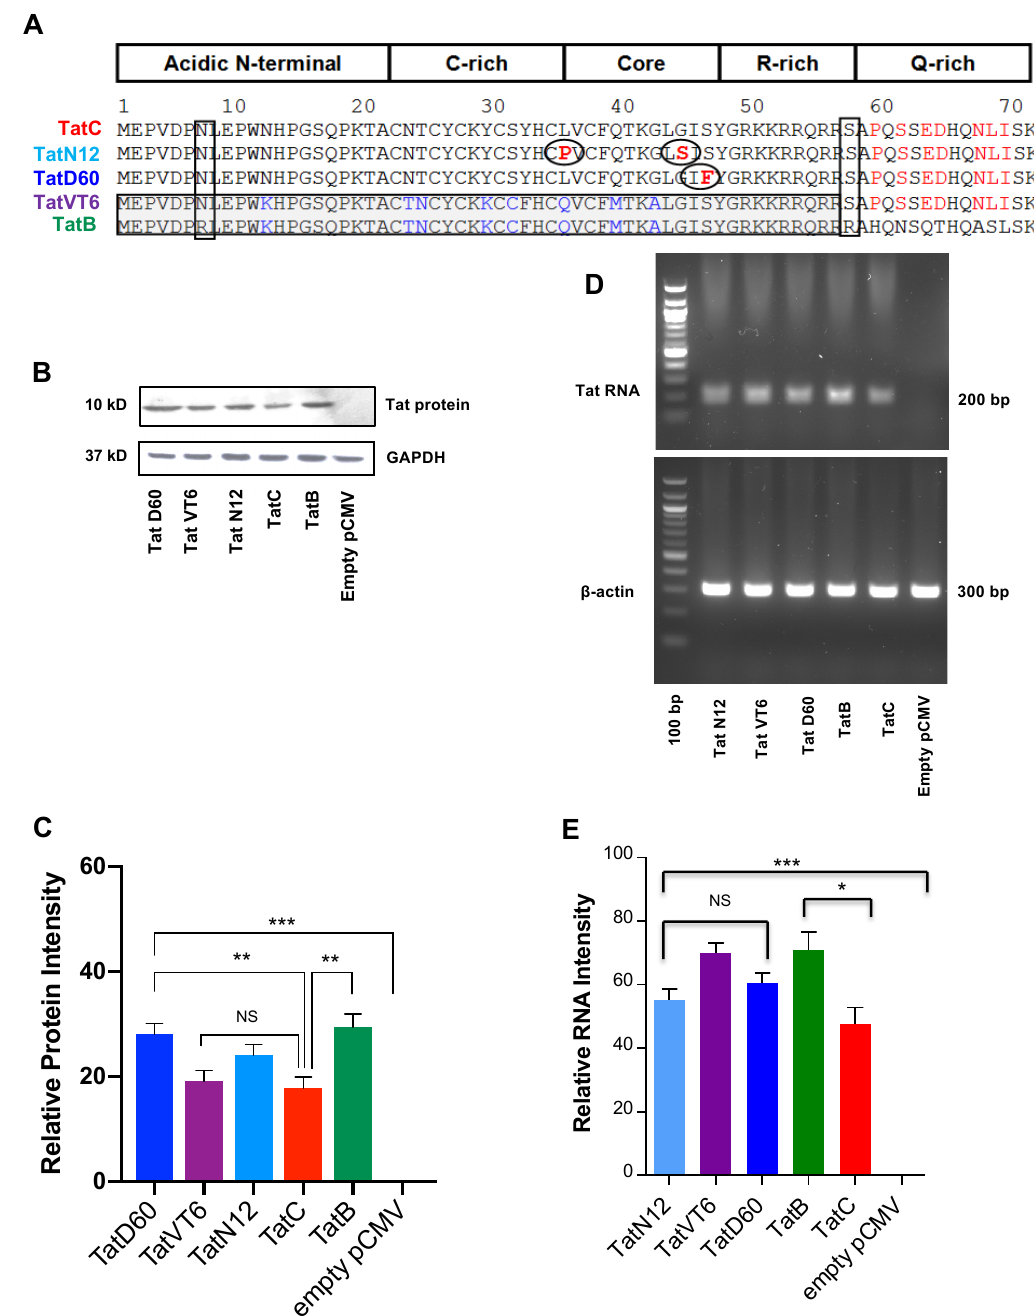
Figure 1. Expression of Tat subtypes and variants at protein and transcriptional level. Panel ( A ) A comparison of the sequence between TatB subtype (A HIV-1 NL4-3 Infectious Molecular Clone (pNL4-3); accession No. U26942.1) with the Indian isolate TatC (clone 93IN905; accession No.AF067158) revealed conserved (9 aa) change in the amino acid sequences. Our TatC variants, TatN12 (accession No. HQ110625), a subtype C variant with Leucine35Proline and Glycine44Serine; TatD60 (accession No. HQ110614), also a subtype C variant with Glutamic_acid9Lysine, Serine46Phenylalanine and Serine61Arginine; and TatVT6 (accession No. FJ432073), a B / C recombinant having N-terminal, C-rich, Core and R-rich regions from subtype TatB whereas the Q-rich region was from subtype TatC. Panel ( B and C ) Tat variants (TatN12 or TatVT6 or TatD60) or Tat subtypes (TatB or TatC) or empty pCMV-Myc vector were checked for intracellular expression by transfecting (1 µ g plasmid DNA / well in 1 × 10 6 cells) on Human embryonic kidney 293 expresses a mutant version of the SV40 large T antigen